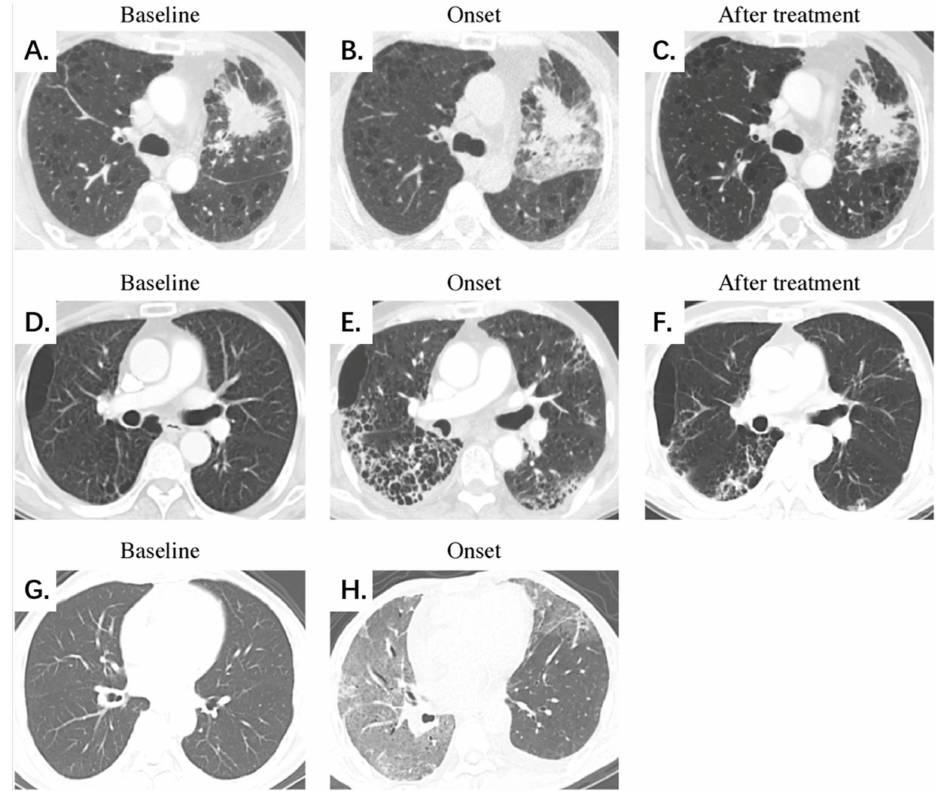
Figure 3. Representative chest CT scans of mild, severe, and fatal CIP at different stages. ( A – C ) Mild CIP with an OP pattern. A 51-year-old male patient with lung adenocarcinoma was treated with a PD-1 inhibitor combined with chemotherapy. Chest CT on day 24 after ICI initiation demonstrates localized development of GGOs, consolidation, and reticular opacities mainly surrounding the tumor lesion. The patient presented symptoms of dyspnea, cough, and wheezing. The extent, image finding, and clinical symptom scores were 6, 3, and 3 points for the whole lung, respectively, and CIP demonstrates significant absorption after oral corticosteroid treatment. ( D – F ) Severe CIP with an NSIP pattern. A 64-year-old male patient with squamous cell lung carcinoma was treated with a PD-1 inhibitor combined with chemotherapy. Chest CT on day 38 after ICI initiation demonstrates a diffuse development of GGOs, consolidation, reticular opacities, interlobular septal thickening, honeycombing, and a small amount of pleural effusion dominated subpleural distribution. The patient presented symptoms of dyspnea, wheezing, fever, and hemoptysis. The extent, image finding, and clinical symptom scores were 18, 6, and 4 points for the whole lung, respectively. CIP shows significant absorption after intravenous corticosteroid treatment. ( G , H ) Fatal CIP with an AIP/ARDS pattern. A 60-year-old male patient with duodenal cancer was treated with a herpes simplex virus type II coding for the granulocyte-macrophage colony-stimulating factor combined with a PD-1 inhibitor. Chest CT on day 78 after ICI initiation demonstrates a diffuse development of GGOs, consolidation, reticular opacities, interlobular septal thickening, and a small amount of pleural effusion, presenting the unusual manifestation of the “crazy paving” sign. The patient presented symptoms of dyspnea, cough, and hemoptysis. The extent, image finding, and clinical symptom scores were 30, 5, and 3 points for the whole lung, respectively. The patient died early of respiratory failure, and no follow-up CT scan was available. Abbreviations: CIP, checkpoint inhibitor-related pneumonitis; PD-1, programmed cell death-1; ICIs, immune checkpoint inhibitors; GGO, ground- glass opacity; OP, organizing pneumonia; NSIP, nonspecific interstitial pneumonia; AIP/ARDS, acute interstitial pneumonia/acute respiratory distress